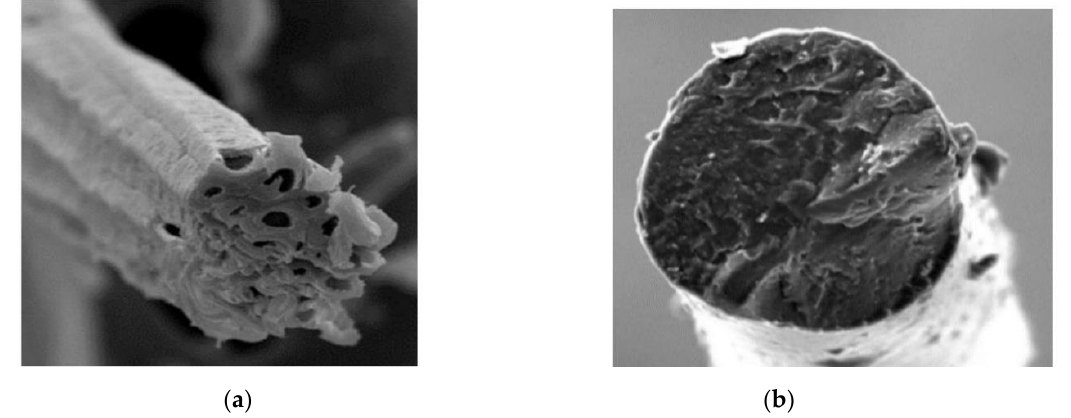
Figure 2. SEM images of jute and PVA fiber: ( a ) jute fiber (50 μm); ( b ) PVA fiber (100 μm).